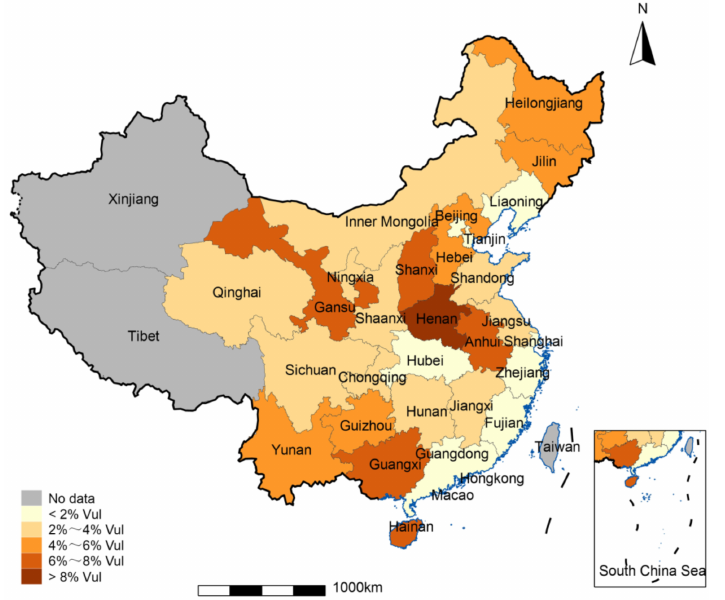
Figure 1. Probability of a household falling into poverty in the future by province (data source: 2017